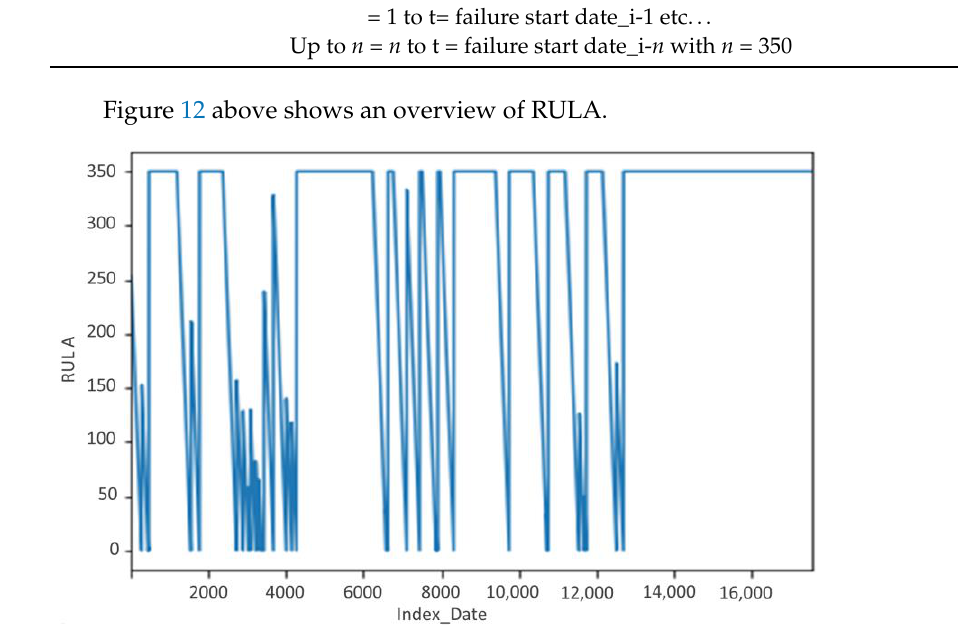
Figure 12. Example of RULA for cluster 1 continuous as a function of the number of hours remaining.